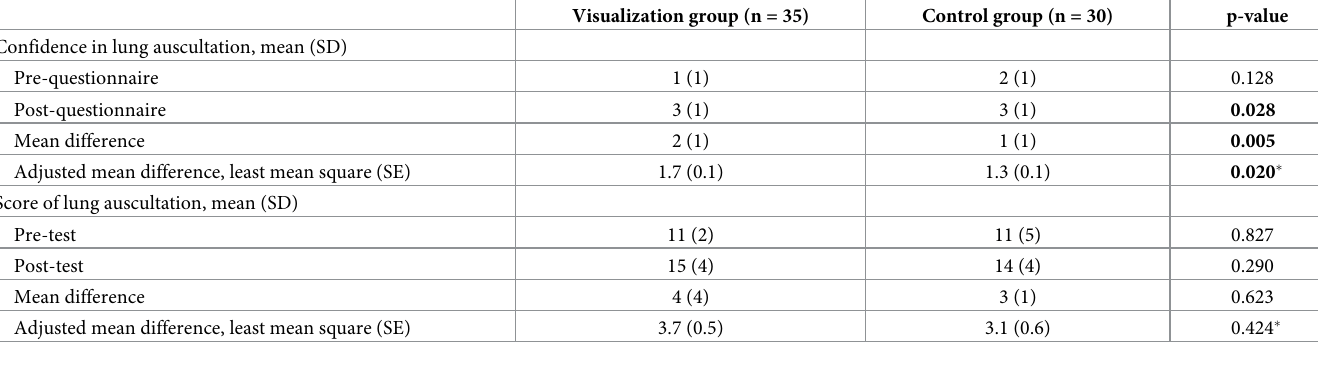
Table 2. Changes in the confidence level pertaining to lung auscultation and the score of lung auscultation before and after education ( n =